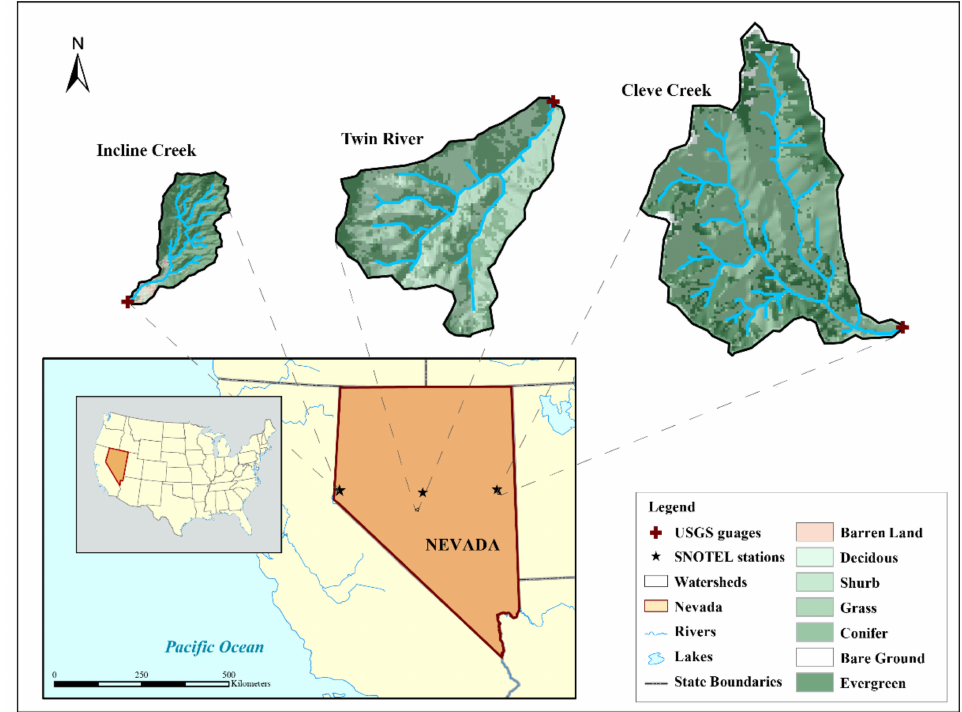
Figure 1. The geographic locations and topographies of the Incline Creek, Twin River, and Cleve Creek watersheds located in the Great Basin of